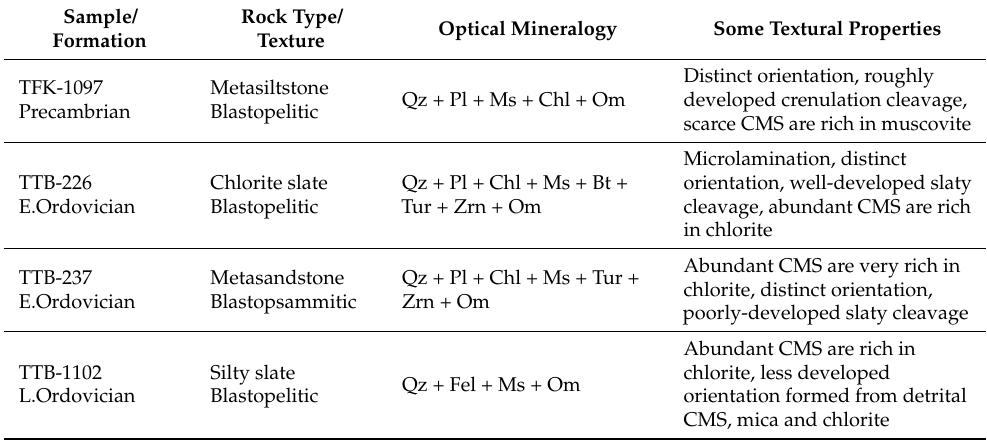
Table 1. Optical mineralogical properties of the studied samples (Qz = Quartz, Pl = Plagioclase, Chl = Chlorite, Ms = Muscovite, Bt = Biotite, Tur = Tourmaline, Zrn = Zircon, Om = Opaque